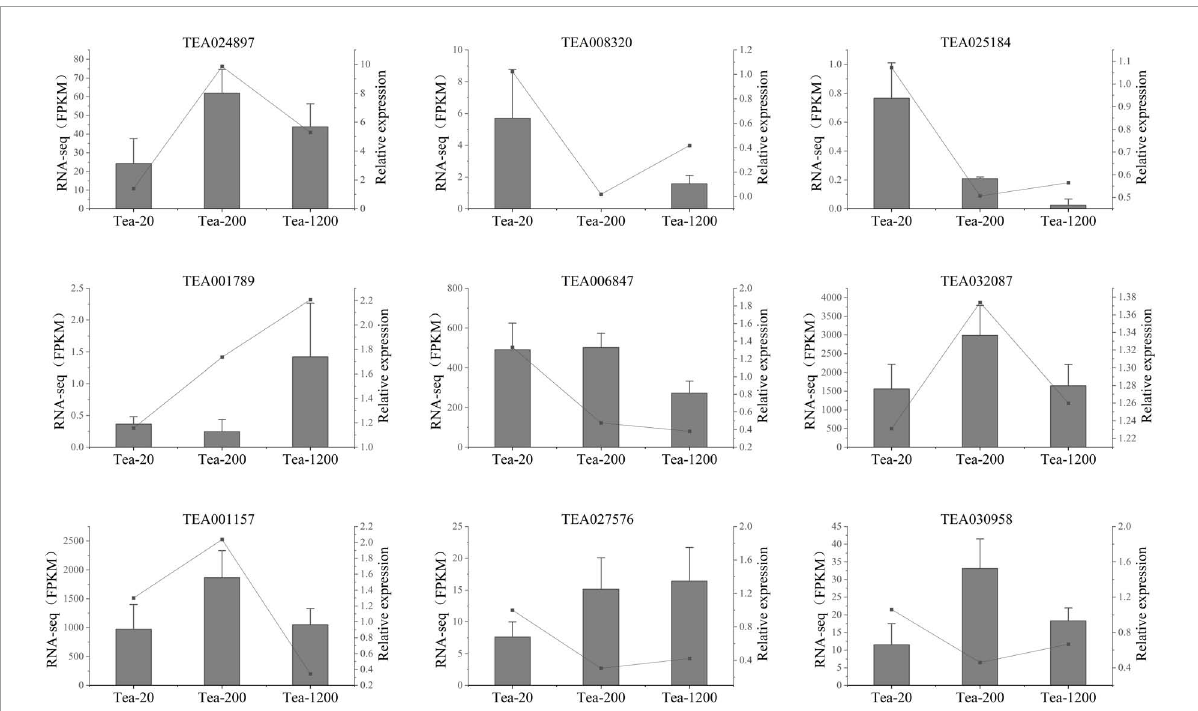
FIGURE7 qRT-PCR verification of transcriptomic sequencing. Fragments per kilobase of transcript per million fragments mapped (FPKM) of transcriptome data (gray columns) and relative expressions of qRT-PCR test (black points) are